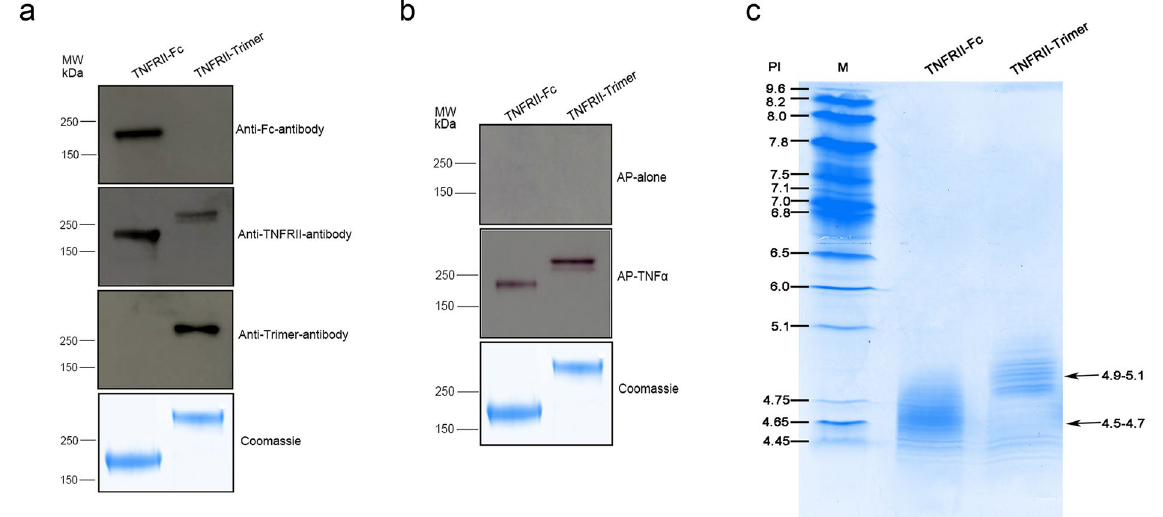
Figure 3. Biochemical characterization of purified TNFRII-Trimer. ( a ) TNFRII-Trimer was analyzed by Western blot under non-reducing conditions to confirm the size and integrity of the fusion protein. 0.2 μ g of TNFRII-Trimer and TNFRII-Fc were analyzed by western blot using antibody against TNFRII-domain, Trimer-domain and Fc-domain, respectively. Full-length blots are included in the Supplementary information ( a ). ( b ) Ligand-receptor affinity staining analysis of TNFRII-Trimer binding to AP-tagged ligands (AP- TNF- α ). TNFRII-Fc (2 μ g) and TNFRII-Trimer (2 μ g) were each separated by non-reducing SDS-PAGE and either visualized by Coomassie brilliant blue staining or transferred to a PVDF membrane, followed by in situ detection with AP-TNF- α . Both TNFRII-Trimer and TNFRII-Fc were detected by their AP-tagged ligands (AP-TNF- α ) but not by AP alone (negative control). Full-length blots are included in the Supplementary information ( b ). ( c ) IEF was performed in fusion protein TNFRII-Trimer and TNFRII-Fc. The PI value of TNFRII-Trimer and TNFRII-Fc is shown, respectively. M represented marker.